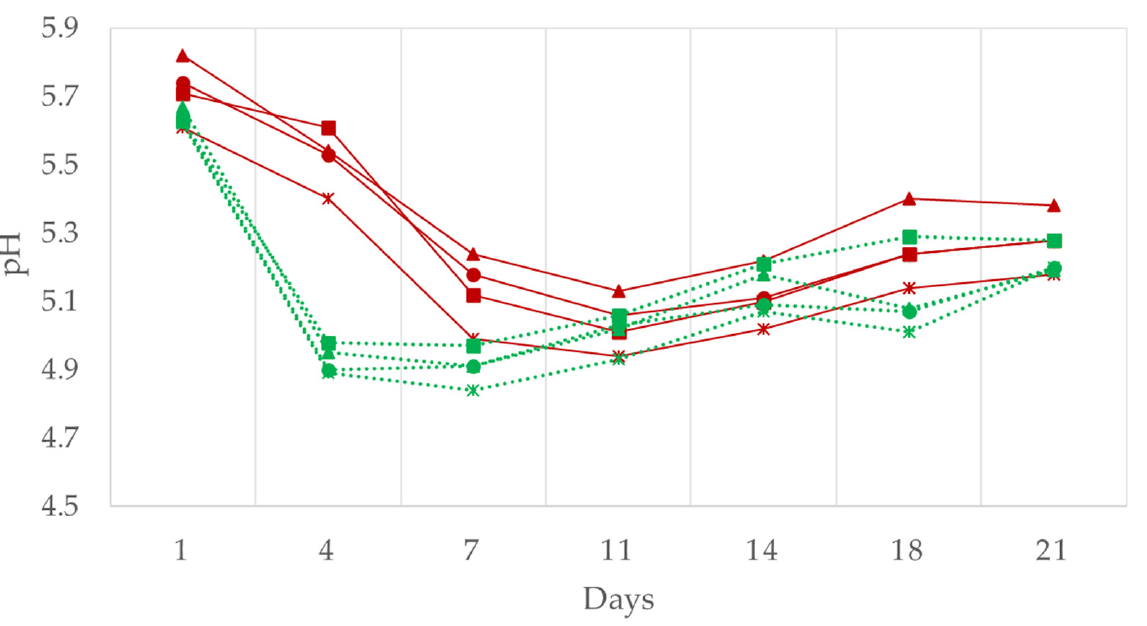
Figure 2. The effect of replacing pork backfat with high oleic sunflower oil on pH in the traditional and reduced fat “Chorizo Zamorano” formulations during ripening. Traditional: ( ■ ) Control, ( ▲ ) 12.5%, ( ● ) 20%, and (×) 50% of backfat replacement. Reduced fat: ( ■ ) Control, ( ▲ ) 12.5%, ( ● ) 20%, and (×) 50% of backfat replacement.